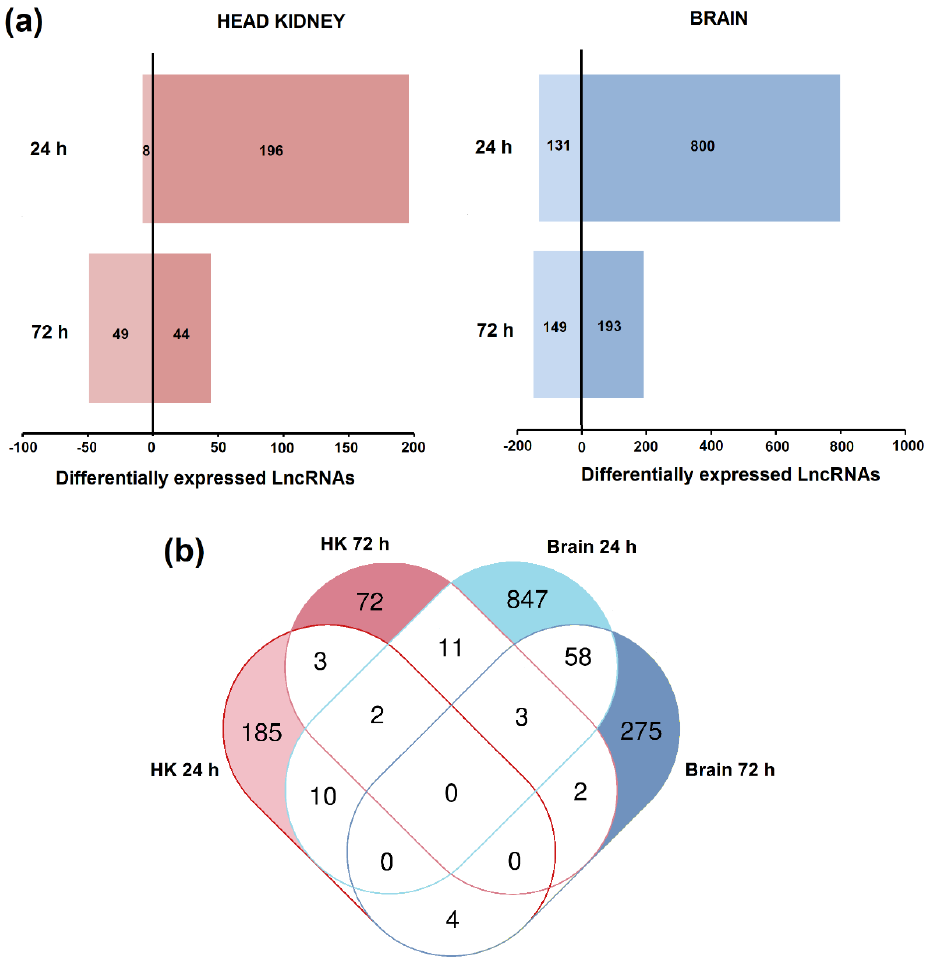
Figure 3. Temporal expression of the predicted lncRNAs after nodavirus infection in head kidney and brain. ( a ) Number of lncRNAs up- and downregulated in each tissue at 24 and 72 hpi with nervous necrosis virus (NNV). ( b ) Venn diagram representing the shared and unshared lncRNAs modulated after NNV challenge in both tissues at the different sampling points.